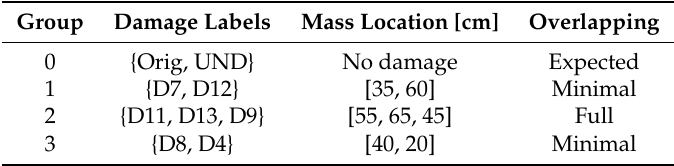
Table 3. Overlap degree of mass location